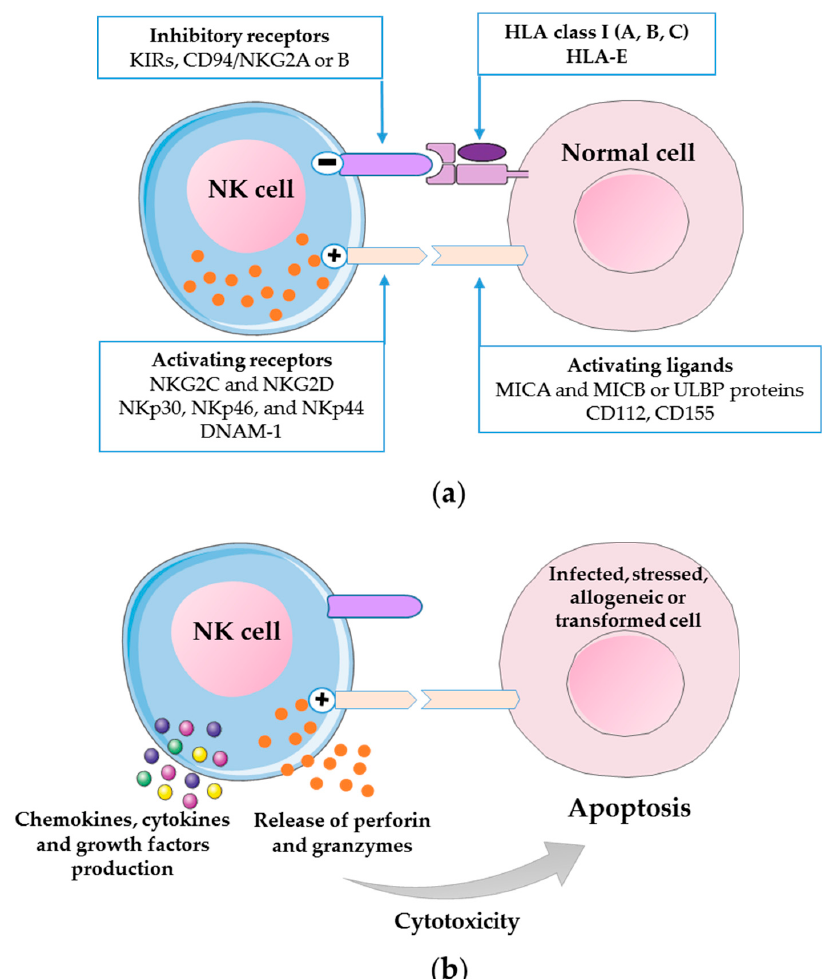
Figure 1. Inhibition and activation of NK cells towards normal and target cells. The cytolytic activity of NK cells is modulated by a balance between activating and inhibitory receptors. ( a ) NK cells towards normal cells. NK cells express inhibitory receptors specific for classical and non-classical Human Leukocyte Antigen (HLA)-I molecules on normal cell. This direct inhibitory interaction induce tolerance towards normal cell by preventing NK cell activation and killing even when NK cell activating receptor binds an activating ligand. ( b ) NK cells towards target cells. Virus-infected, stressed, allogeneic or transformed cells are characterized by downregulation of HLA class I molecules and by an enhanced expression of activating ligands on their surface which promote NK cell activation, leading to cytolysis and killing of these cells by apoptosis through the exocytosis of cytotoxic granules (perforin and granzymes). NK cells also act to promote or suppress functions of innate and adaptive immune cells through their production of chemokines, cytokines and growth factors following their activation by target cells.